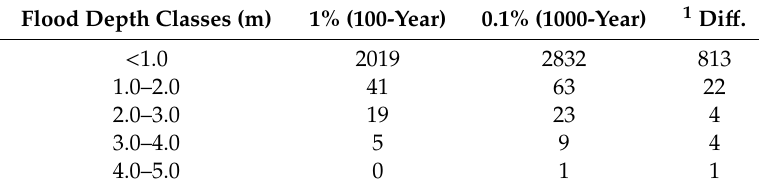
Table 3. Number of potentially a ff ected buildings by di ff erent flood depth classes (m) computed